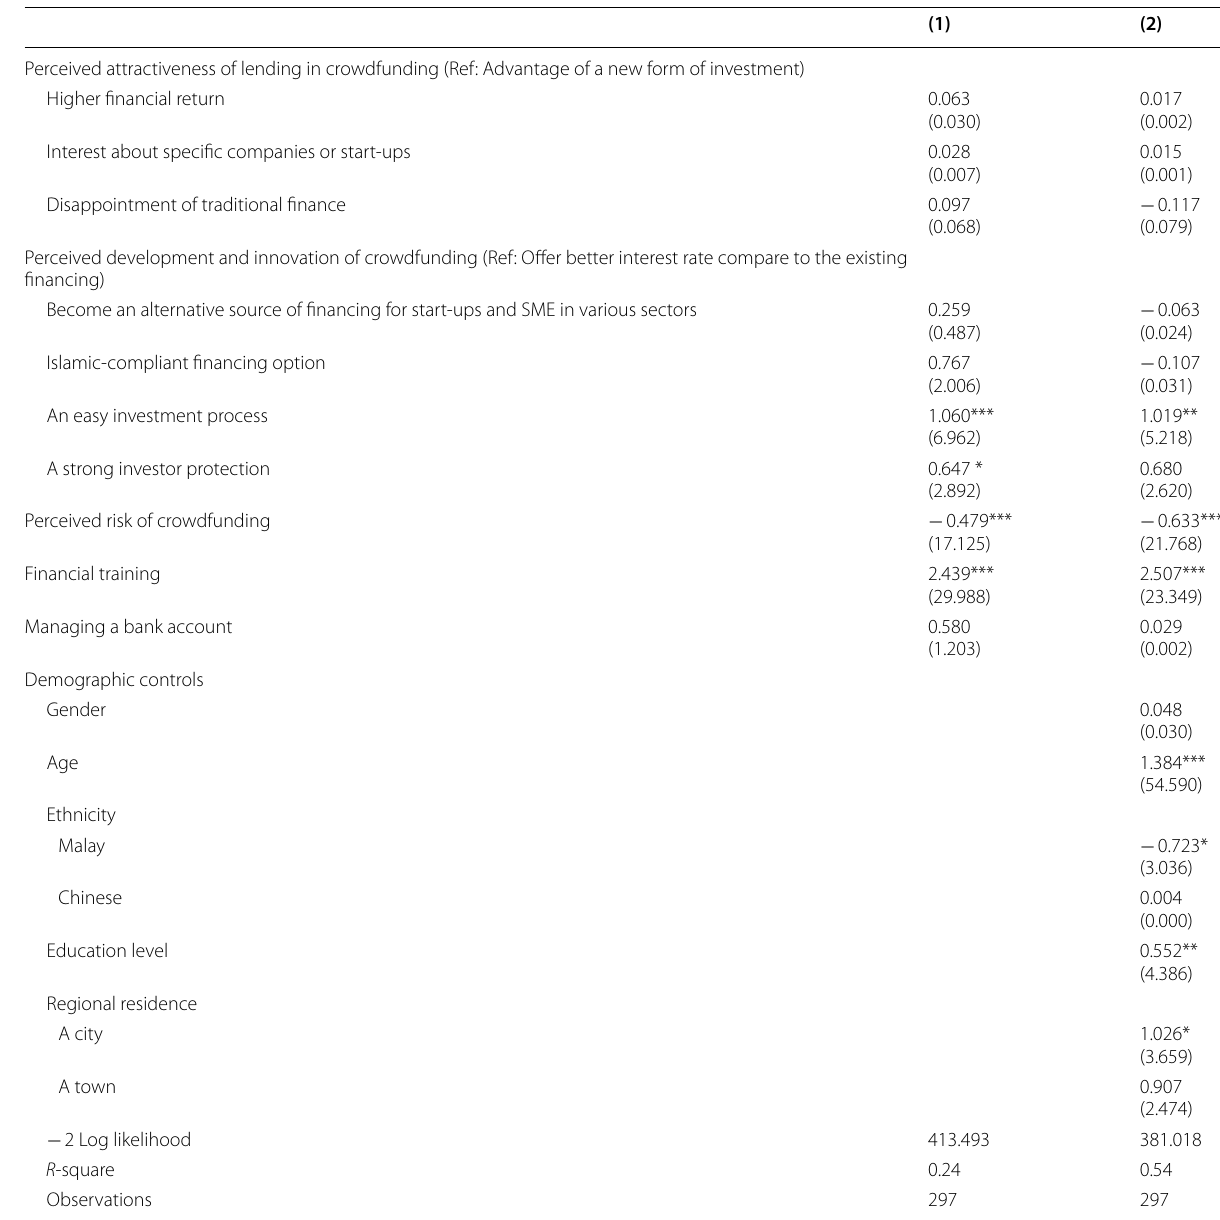
Table 4 Willingness to fund a crowdfunding